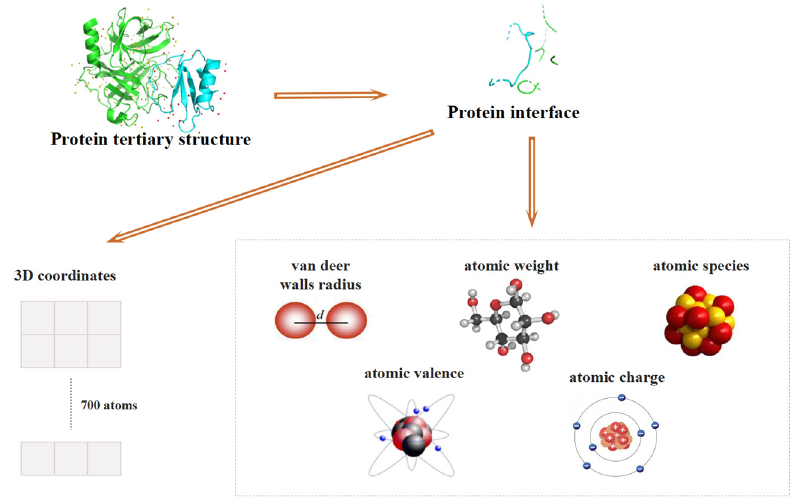
Figure 2. Data preprocessing. Protein interface was extracted because it is the most distinctive and informative region. Then, the interface was converted into point cloud format including spatial coordinates, van der Waals radius, atomic weight, atomic type, atomic valence, atomic charge and atomic chain.